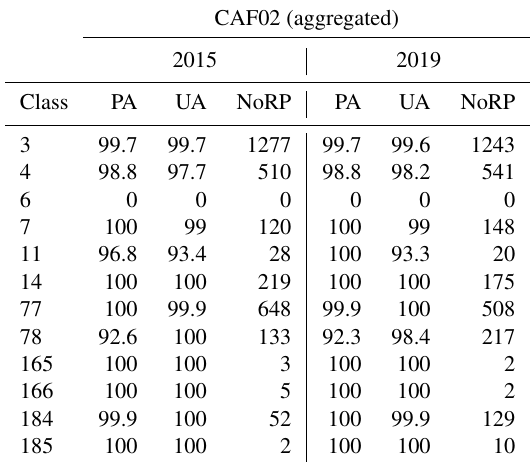
Table B1. Thematic class accuracies per KLC. Accuracy param- eters are in percent; classes with fewer than 15 samples were not included in the overall accuracy calculation. Accuracy results are presented at the aggregated as well as at the modular LCCS levels, depending on the type of mapping (land cover map – modular, land cover change map – aggregated). Class: corresponding class (see Table 2 modular (MCM) or aggregated (AG) map code); PA: pro- ducer’s accuracy; UA: user’s accuracy; NoRP: number of reference